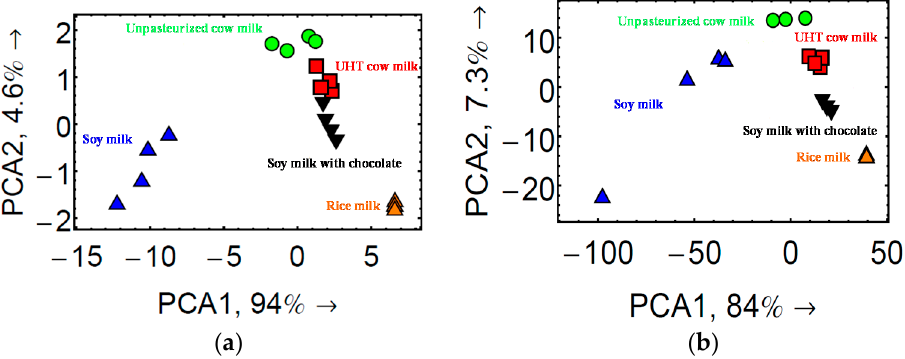
Figure 9. Classification of different milk samples by the eTs with PCA based on 2D CEPs ( a ) and 3D CELs ( b ). For each sample quadruplicate measurements were performed. Reprinted from [31] Copyright@American Scientific Publishers.